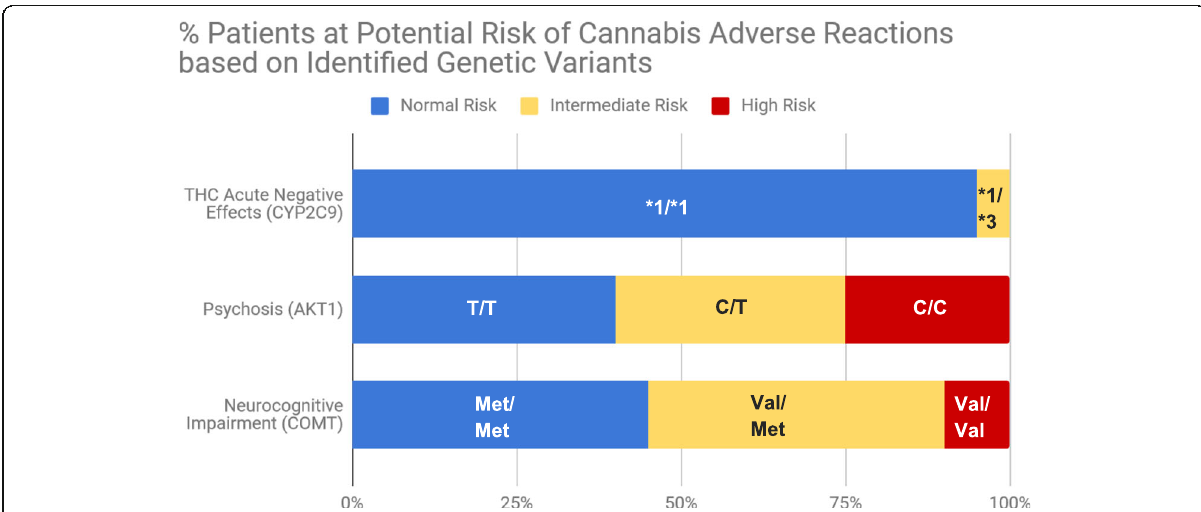
Fig. 1 Pharmacogenetic screening identified 95% of participants having the CYP2C9*1/*1 genotype (suggesting normal THC metabolism), with 5% at potential risk of developing THC acute negative effects including anxiety, hallucinations, paranoia, rapid heart rate and panic attacks. Furthermore, 35 and 25% had AKT1 genotypes suggesting intermediate risk (C/T genotype) or high risk (C/C genotype), respectively, for cannabis- induced psychosis; and 45 and 10% had COMT genotypes suggesting intermediate risk (Val/Met genotype) or high risk (Val/Val genotype), respectively for cannabis-induced neurocognitive